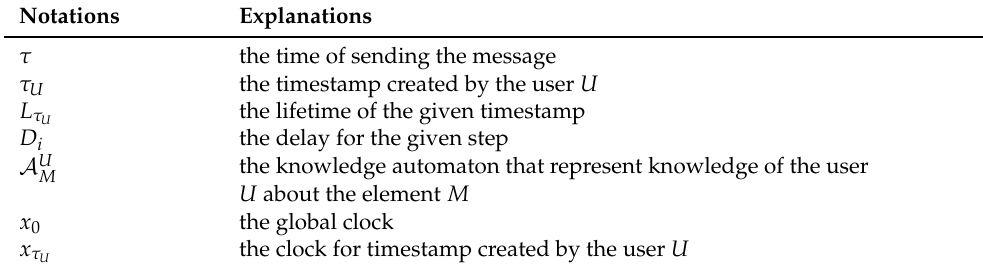
Table 2. Additional